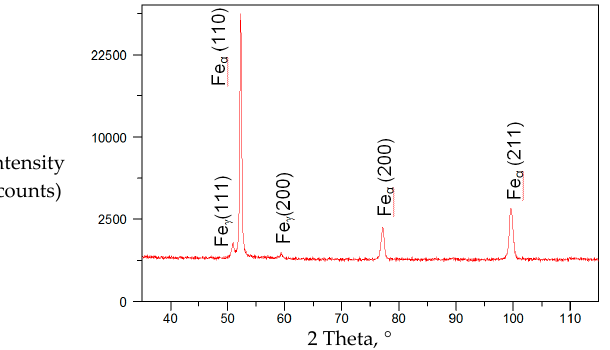
Figure 6. X-ray diffraction of the butt weld made in steel S700MC using the MAG method and a linear energy of 8 kJ/cm.